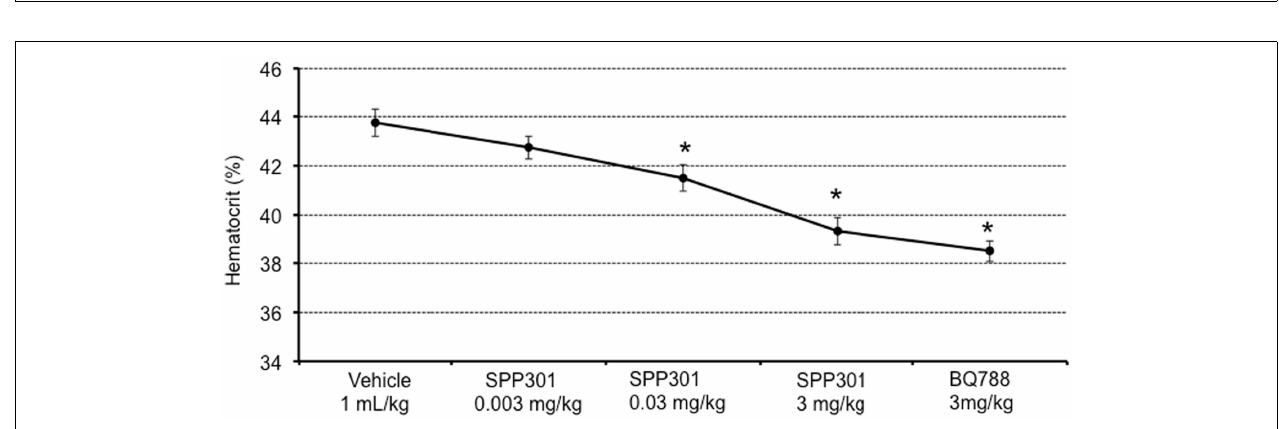
FIGURE 5 | Hematocrit (%) in male SD rats treated with incremental doses of SPP301 (0.003; 0.03; 3mg/kg) followed by BQ-788 (3mg/kg). * p < 0.05 compared with control (vehicle).